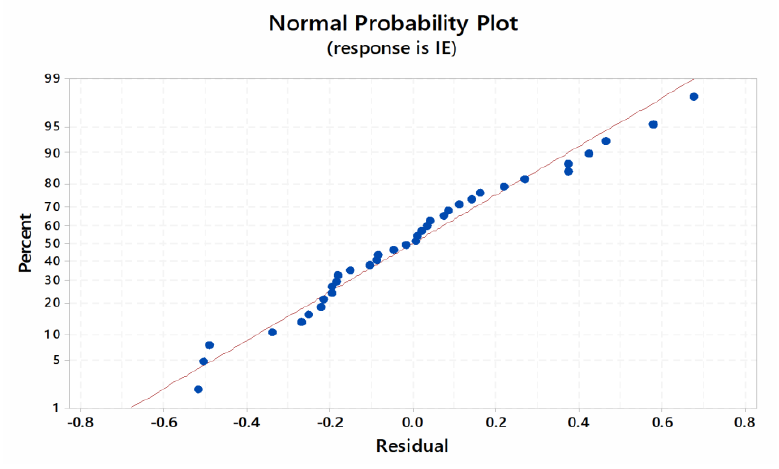
Fig. 3. Normal probability plot of IE.